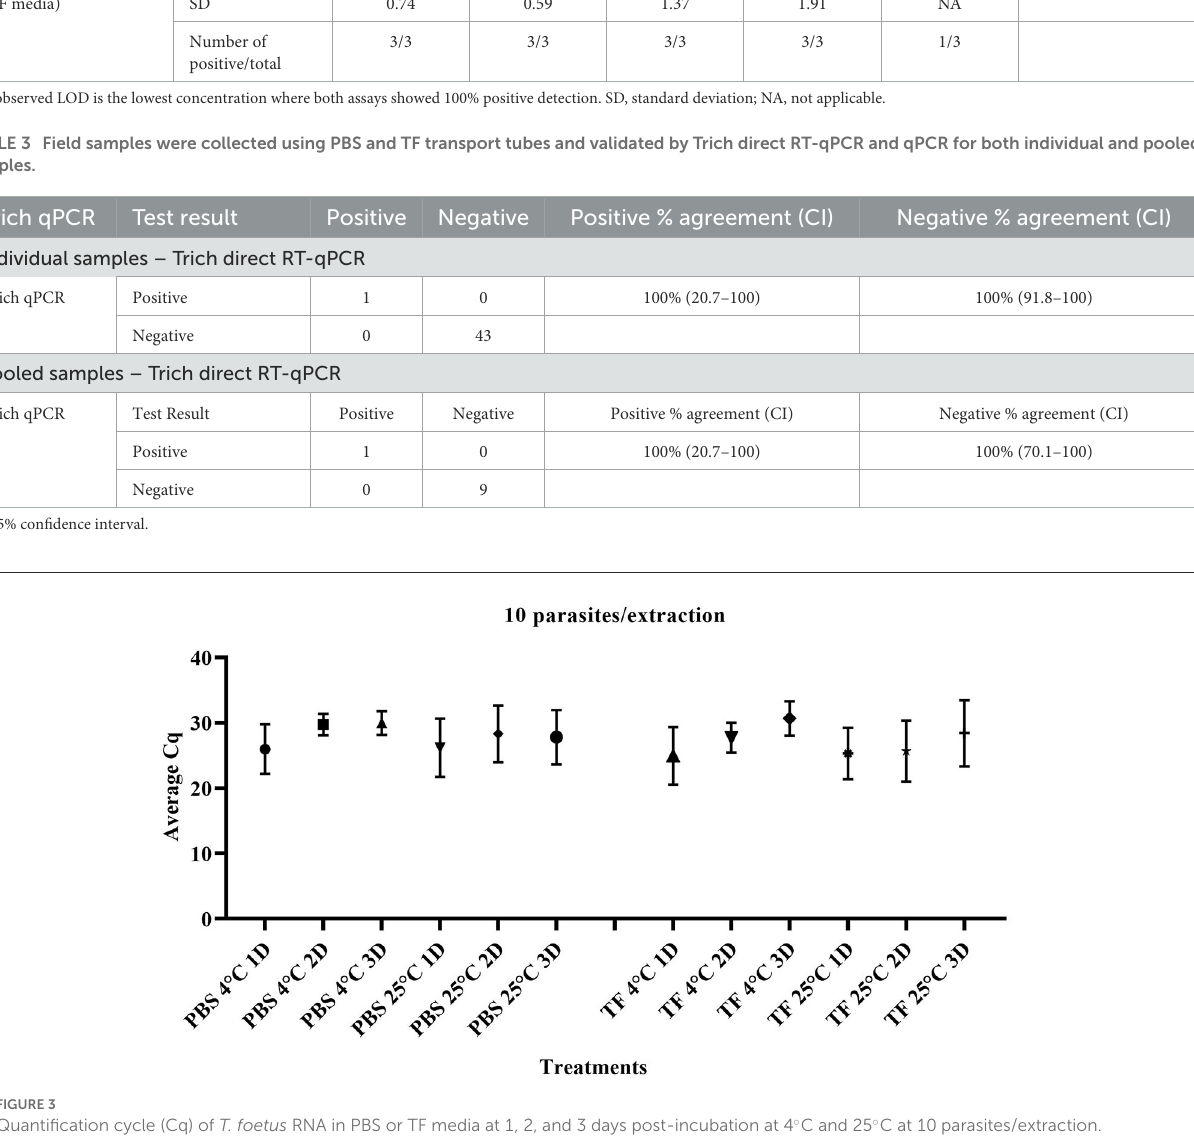
Surveillance of trich direct-qPCR